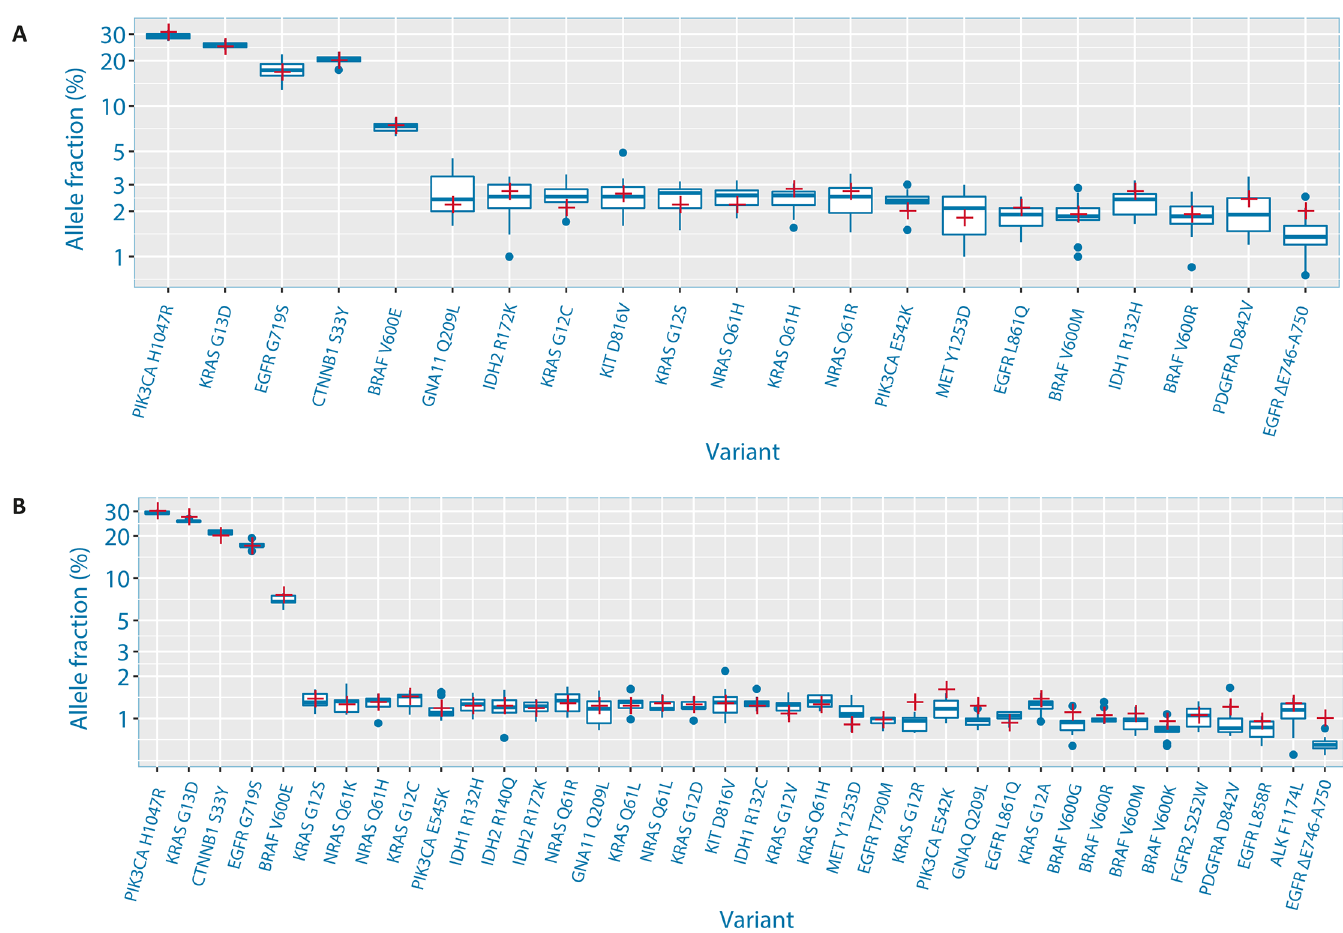
Fig 3. Plot showing allele fractions determined by analysis with eTAm-Seq technology (blue boxplot) and digital PCR (red cross) for analysis of mutations present in both the InVision liquid biopsy tumor profiling panel and (A) Tru-Q 6 and (B) Tru-Q 7.